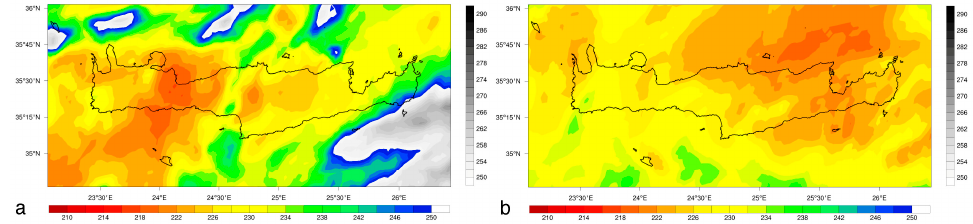
Figure 13. METEOSAT infrared brightness temperature (IR 10.8 µ m), valid ( a ) at 0000 UTC 25 February 2019 and ( b ) at 1200 UTC 25 February 2019. Cloud top brightness temperatures colder than 250 K are colored.